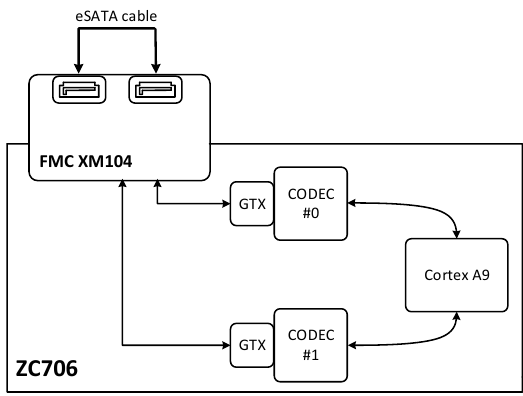
Figure 4. Architectural diagram of